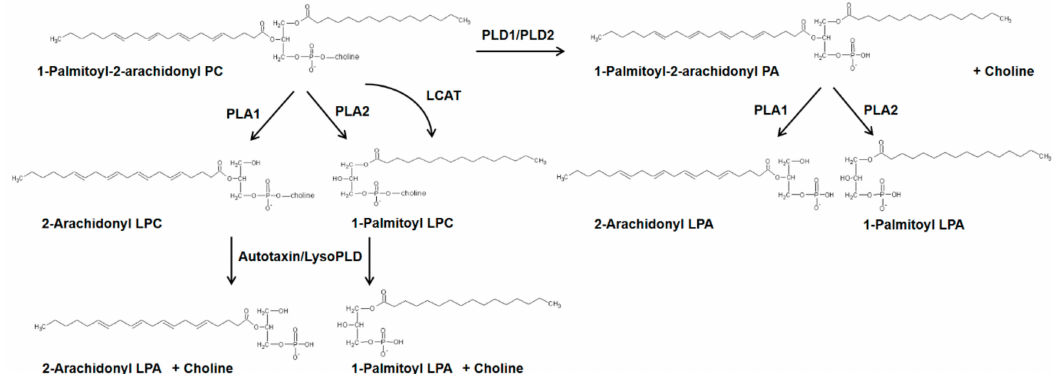
Figure 4. Generation of lysophosphatidic acid by two di ff erent pathways in mammalian cells. Schema showing the conversion of 1-Palmitoyl-2-arachidonyl phosphatidylcholine to LPA by the metabolizing enzymes, PLD, PLA 1 , PLA 2 , and autotaxin or lyso PLD. LCAT—lecithin-cholesterol acyltransferase, LPA—lysophosphatidic acid, LPC—lysophosphatidylcholine, lyso